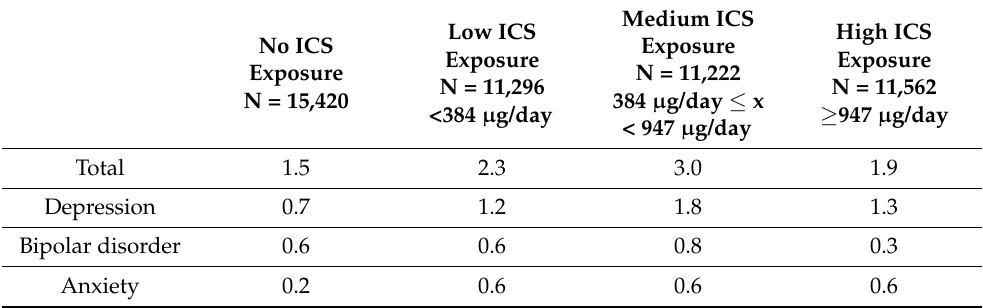
Table A4. Number of psychiatric hospital admissions per 100,000 patient study